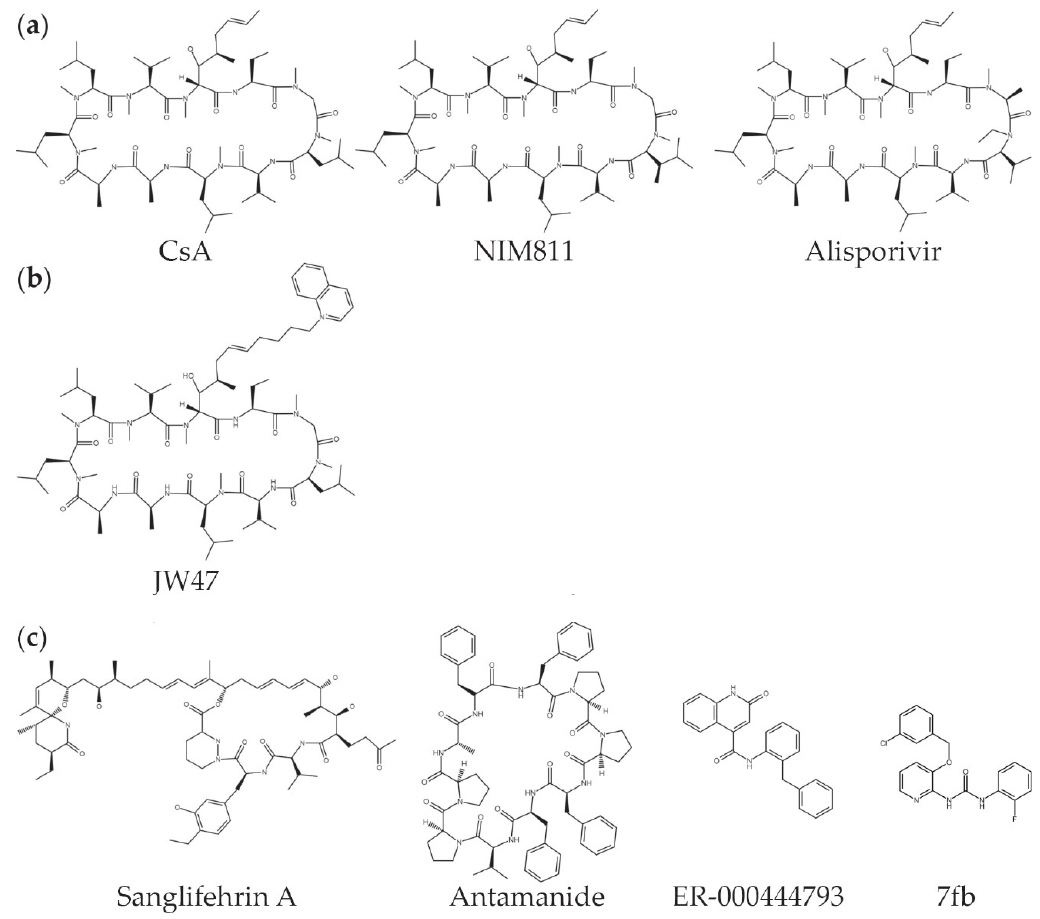
Figure 2. Structures of various CyPD inhibitors. ( a ) Cyclosporin A (CsA) and two of its common derivatives, NIM811 ((Me-Ile-4)cyclosporin A), and Alisporivir (Debio-025, MeAla(3)EtVal(4)-cyclosporin). ( b ) To increase its concentration in the mitochondrial matrix, a positively charged, quinolinium cation was tethered to CsA to create compound JW47 [155] . ( c ) CyPD inhibitors not derived from CsA include Sanglifehrin A [158] , antamanide [156] , ER-000444793 [157] , and compound 7fb (1-(3-(3-chlorobenzyloxy)pyridin-2-yl)-3-(2-fluorophenyl)) [159] . Structures were drawn using the program “Marvin JS” by ChemAxon at the Fischer Scientific website [162] and based on structures in [163] ( a , b ) and the references given ( b , c ).